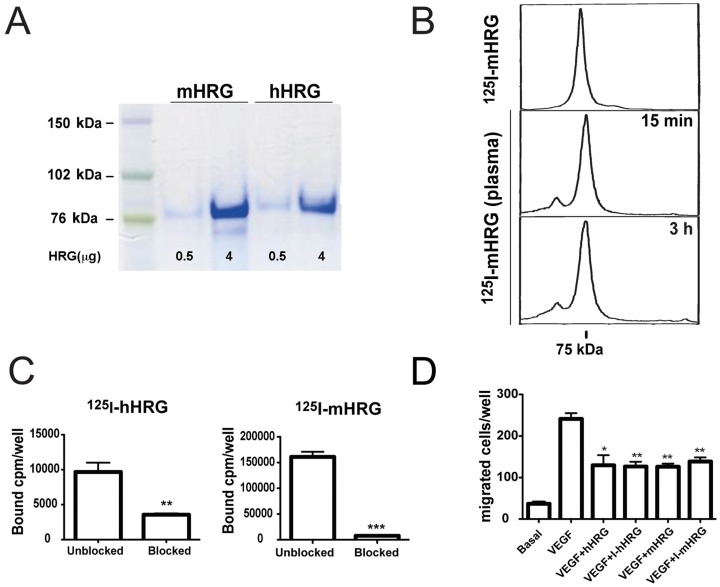
Purification and bioactivity of radiolabeled HRG.A. Coomassie brilliant blue-stained SDS-PAGE showing purified mHRG and hHRG protein (0.5 µg and 4 µg/lane). B. SDS-PAGE analysis of freshly radiolabelled 125I-mHRG (top) and after incubation in murine plasma at 37°C for 15 min (middle) and 3 h (bottom) visualized using Cyclone Storage Phosphor system. C. Binding of 125I-hHRG and 125I-mHRG to heparin-coated plastic in vitro in the presence (blocked) and absence (unblocked) of unlabeled HRG; *p<0.05; Student's t test. D. Inhibition of human umbilical vein endothelial cell migration towards VEGFA by non-radioactive iodinated hHRG and mHRG (HRG-I). *p<0.05; **p<0.01; Student's t test.